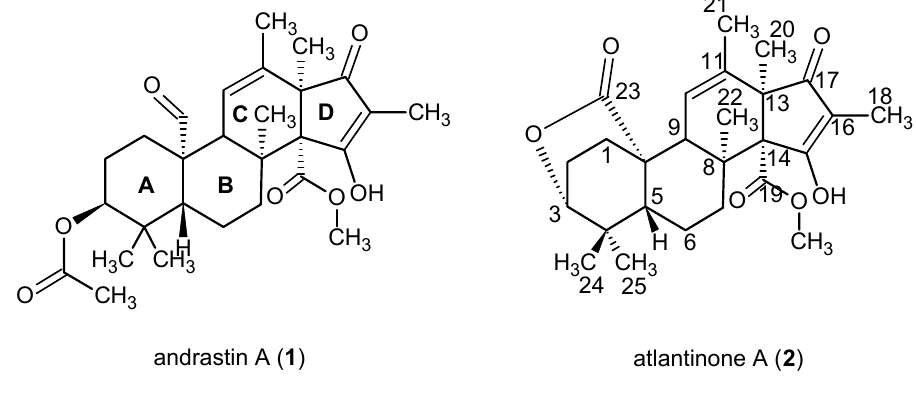
Figure 1. Structures of andrastin A ( 1 ) and atlantinone A ( 2 ). Rings A–D are indicated for ( 1 ) and numbering of the carbon skeleton in ( 2